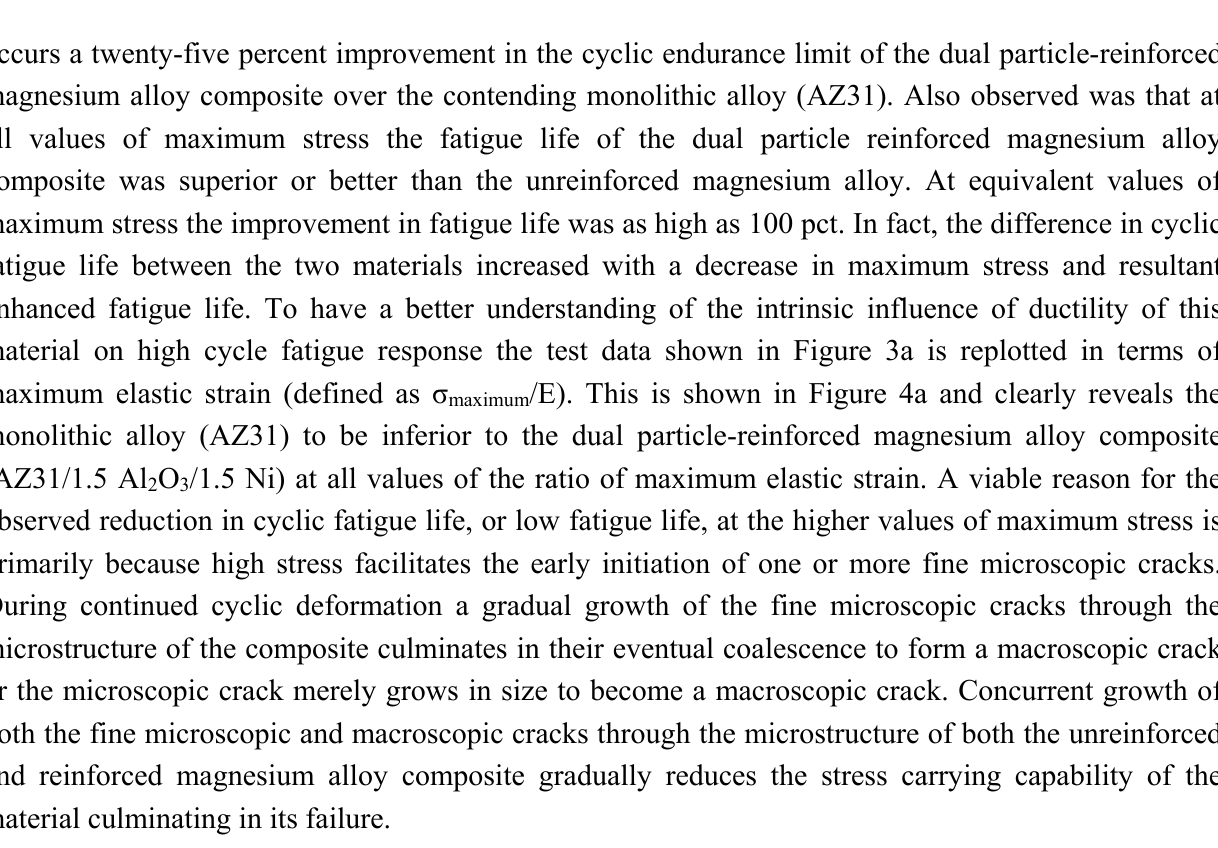
) of the dual f O + Ni) with the unreinforced matrix 2 3